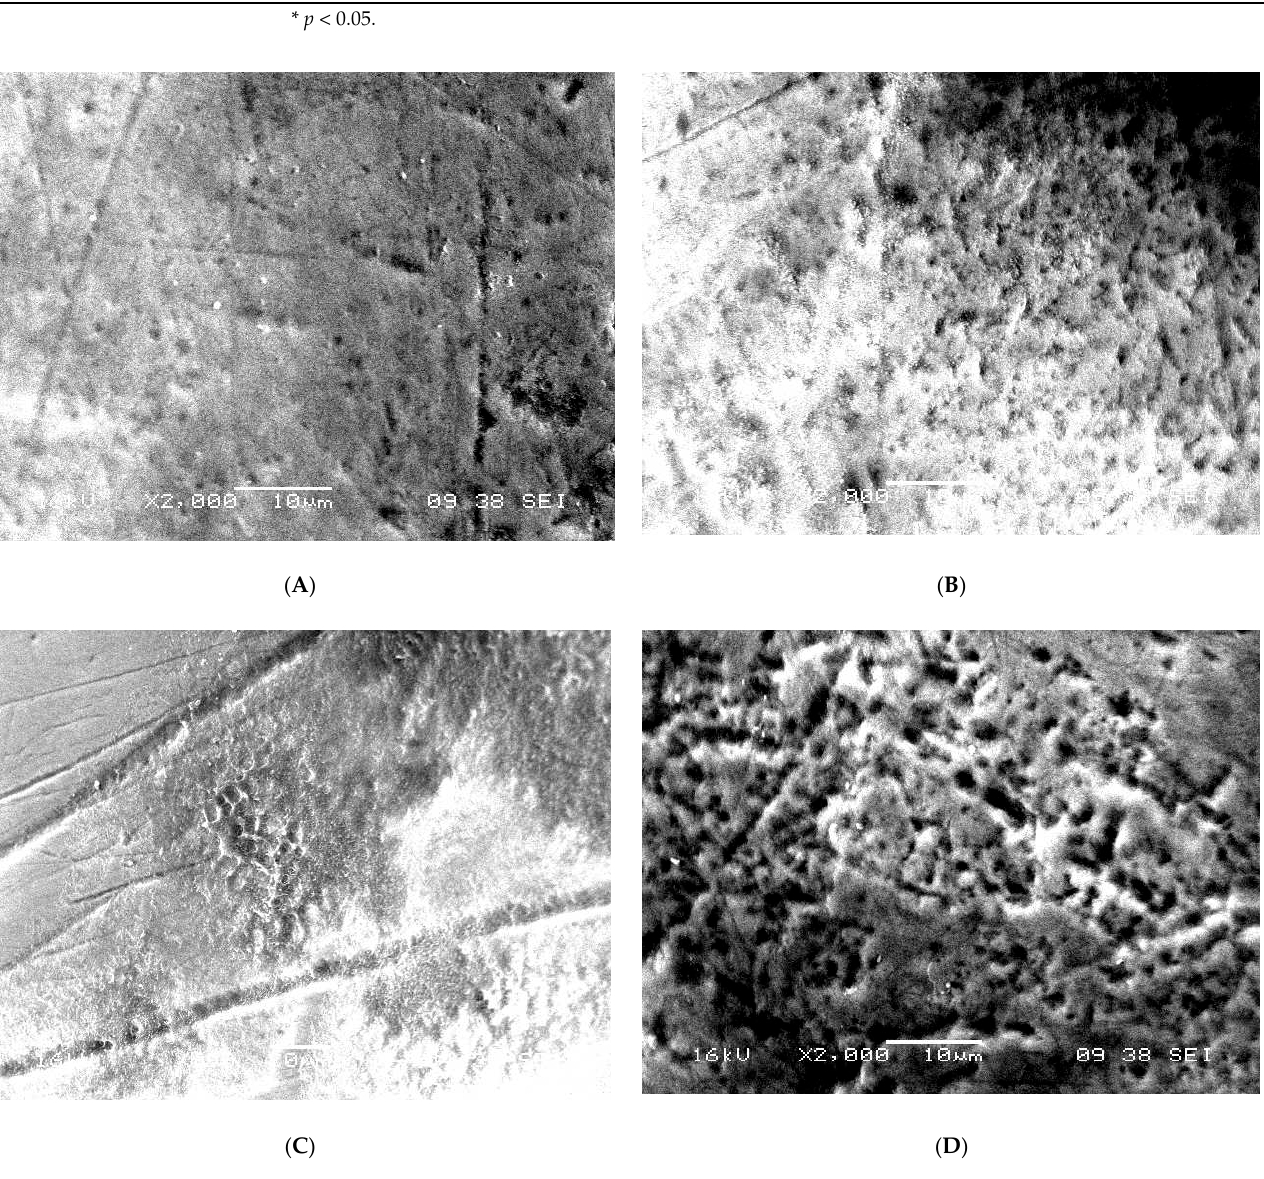
Figure 2. ( A ) SEM image of the labial surface of primary tooth showing normal enamel surface with perforations and craze line-like depressions in a diabetic patient; ( B ) SEM image of the labial surface of primary tooth showing enamel surface with perforations in a diabetic patient; ( C ) SEM image of the labial surface of primary tooth showing enamel surface with perforations and deep craze line-like depressions in a diabetic patient; ( D ) SEM image of the labial surface of primary tooth showing enamel surface with numerous perforations.